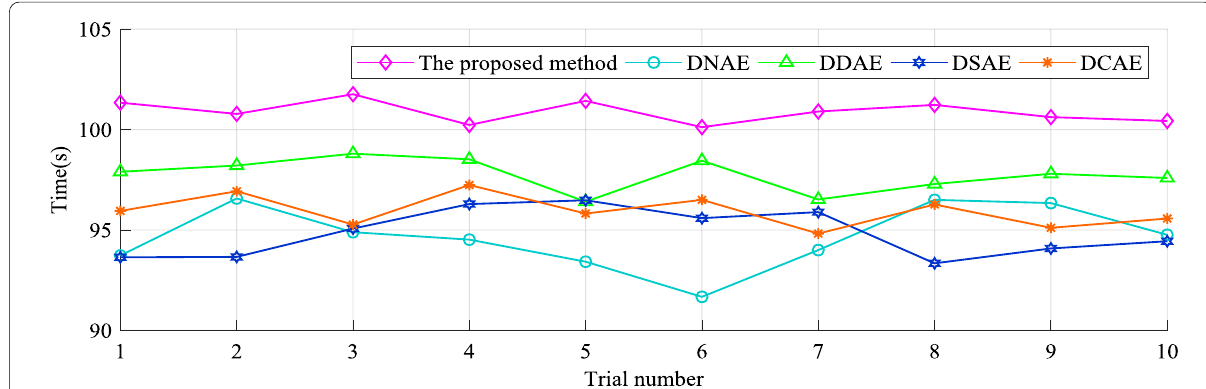
Figure 10 Detailed results of time cost with different methods for 10 experiments